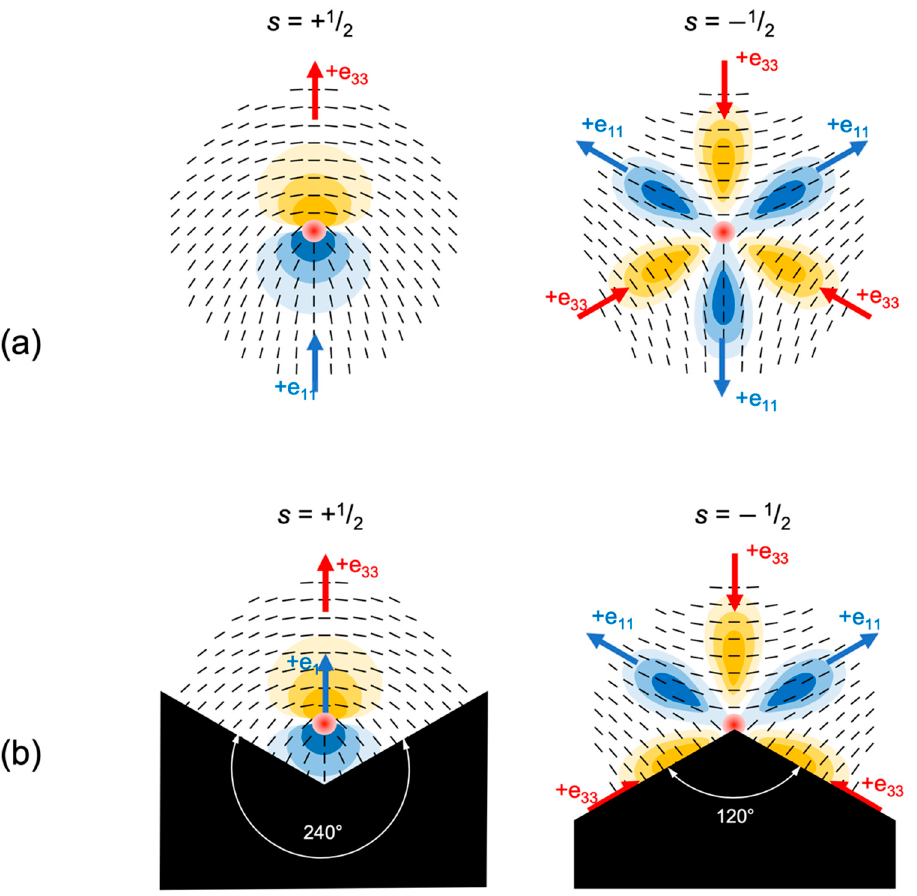
Figure 3. Schematic representations of the flexoelectric polarity associated with +½ (LHS) and − ½ (RHS) defects (adapted from [17]). In the bulk ( a ), the +½ defect has polar symmetry and can be moved with an applied electric field, but the − ½ defect has tripolar symmetry and will not translate under the influence of an applied electric field. When stabilised by surface curvature ( b ), the defects both can be propelled either parallel or antiparallel to the surface normal by the applied field. Bend distortions characterised by e 33 are shown in orange, whereas the splay distortions and e 11 shown in blue.